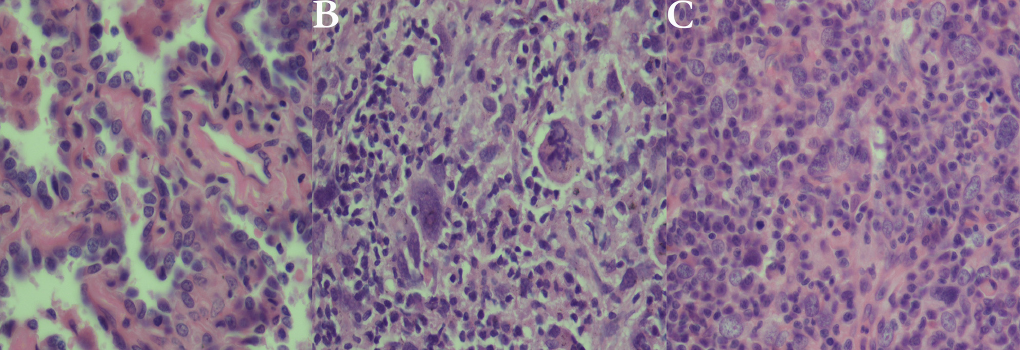
Fig 2. Photomicrographs of ground-glass opacity (GGO) (hematoxylin-eosin stain, original magnification, ×400). (A) A case of atypical adenomatous hyperplasia (AAH) with a well-defined boundary and pulmonary mesenchyme. (B) A case of adenocarcinoma in situ (AIS) with growth restricted to preexisting alveolar walls. No foci of invasion or scarring are seen. (C) A case of minimally invasive adenocarcinoma (MIA) consisting primarily of lepidic growth with a small area of acinar invasion.